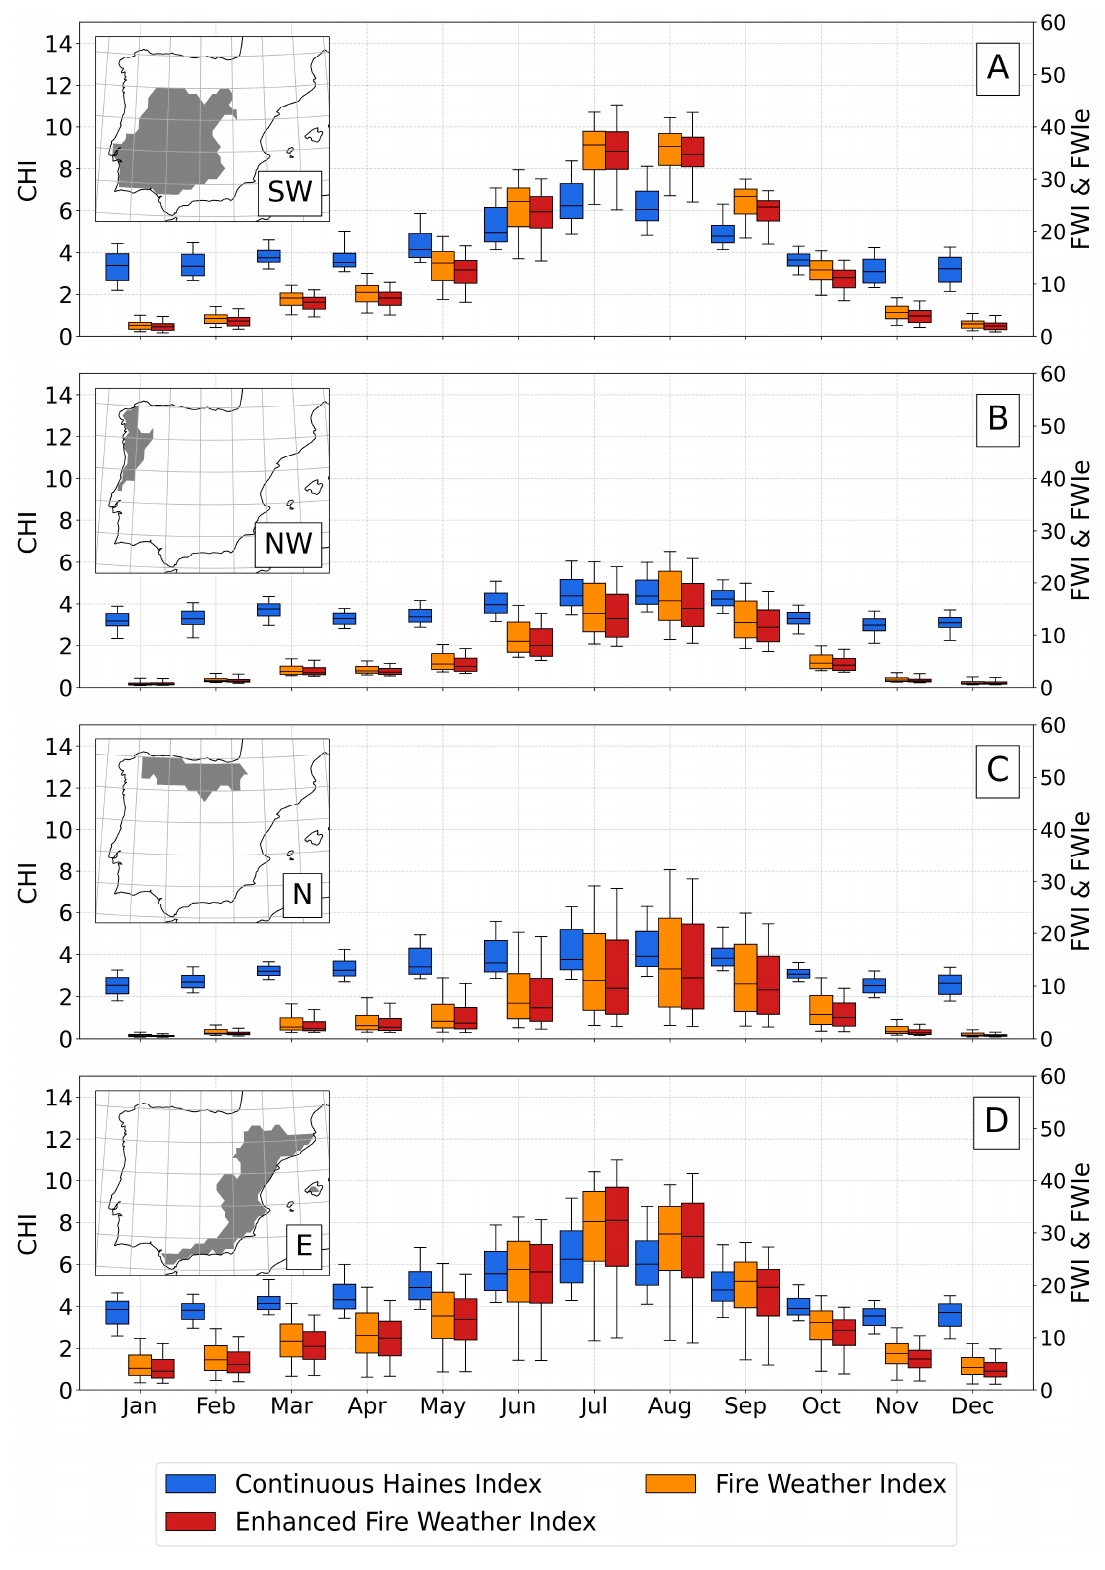
Figure 3. Annual cycles for each of the 4 clusters, ( A ) SW, ( B ) NW, ( C ) N and ( D ) E, during the period 1980–2020 for CHI (blue boxes), FWI (orange boxes), and FWIe (red boxes). The scale for CHI is on the left-hand y -axis, and the scale for FWI and FWIe is on the right-hand y -axis. FWI, in comparison with CHI, had a more well-defined seasonality, with higher values and variability in the summer months (Figure 3A–D) and maximum median values around the 35 and 95th percentile maximums reaching 45. The SW cluster (Figure 3A) was